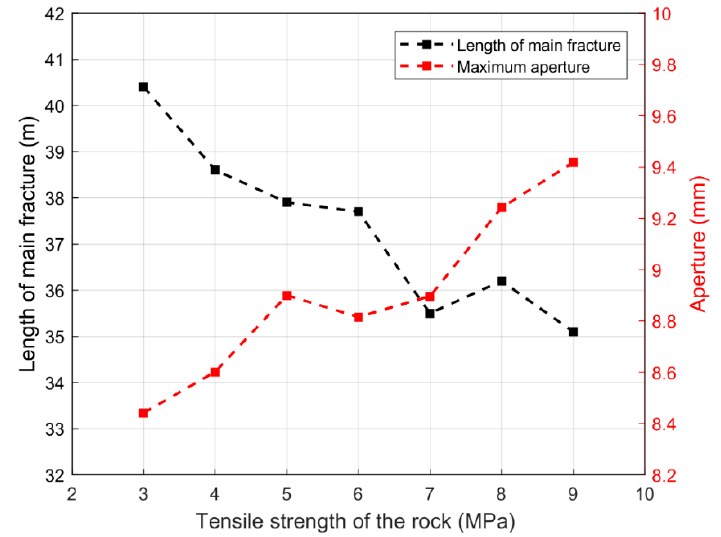
Figure 18. Fracture length under different tensile strengths of rock.